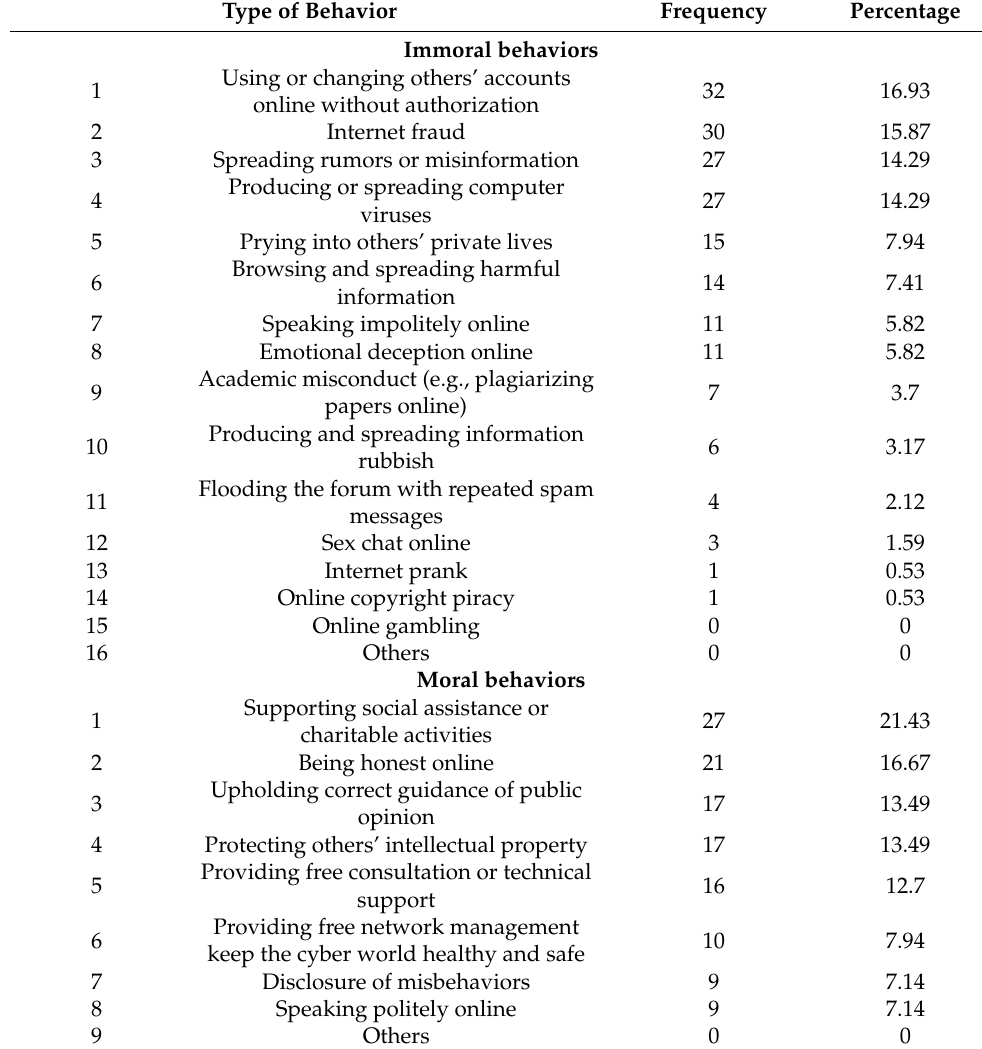
Table 1. Frequency distribution of the